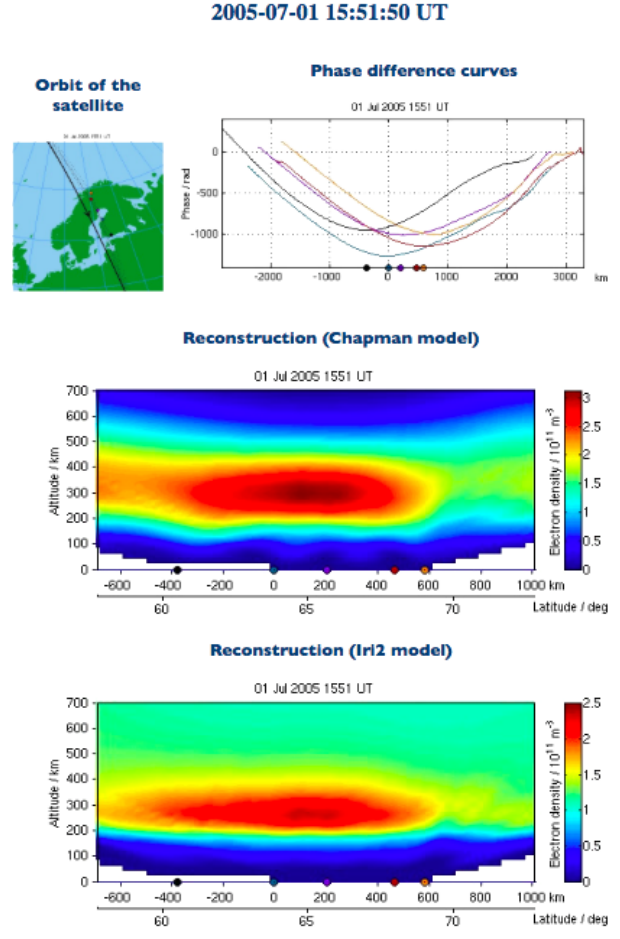
Figure 3. Tomographic reconstruction result from Sodankylä Geo- physical Observatory. The satellite trajectory, observed phase differ- ence curves and tomographic results with two different prior mod- els. The receiver stations are shown as coloured points. The origin of the kilometre axis is placed on Kokkola station.